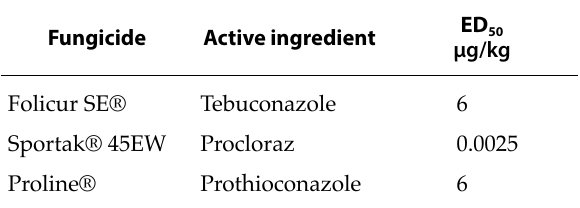
Table 2. Fungicides used to modify the maize-based me- dium, their active ingredients, dosage of active ingredient and ED 50 concentrations (Formenti et al. ,